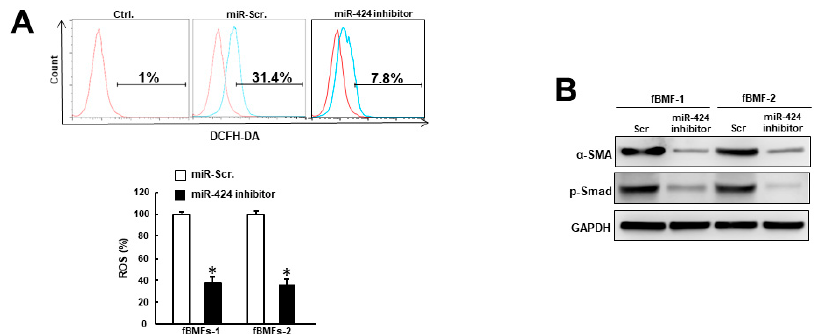
Figure 3. Repression of miR-424 in fBMFs decreases oxidative stress and the expression of fibrosis markers. ( A ) Intracellular reactive oxygen species (ROS) generation was decreased in fBMFs with miR-424 inhibitor using the 2 ′ ,7 ′ -dichlorodihydrofluorescein diacetate (DCFH-DA) method. ( B ) The expression levels of α -SMA and phosphorylated Smad in fBMFs were inhibited when miR-424 was suppressed. *p < 0.05 compared to miR-Scr. group.